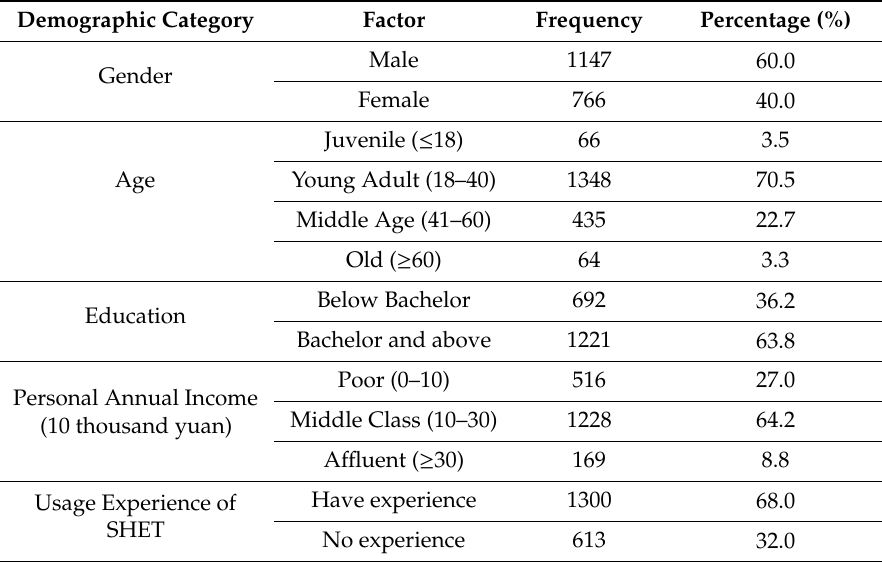
Table 3. The demographic information for the respondents.